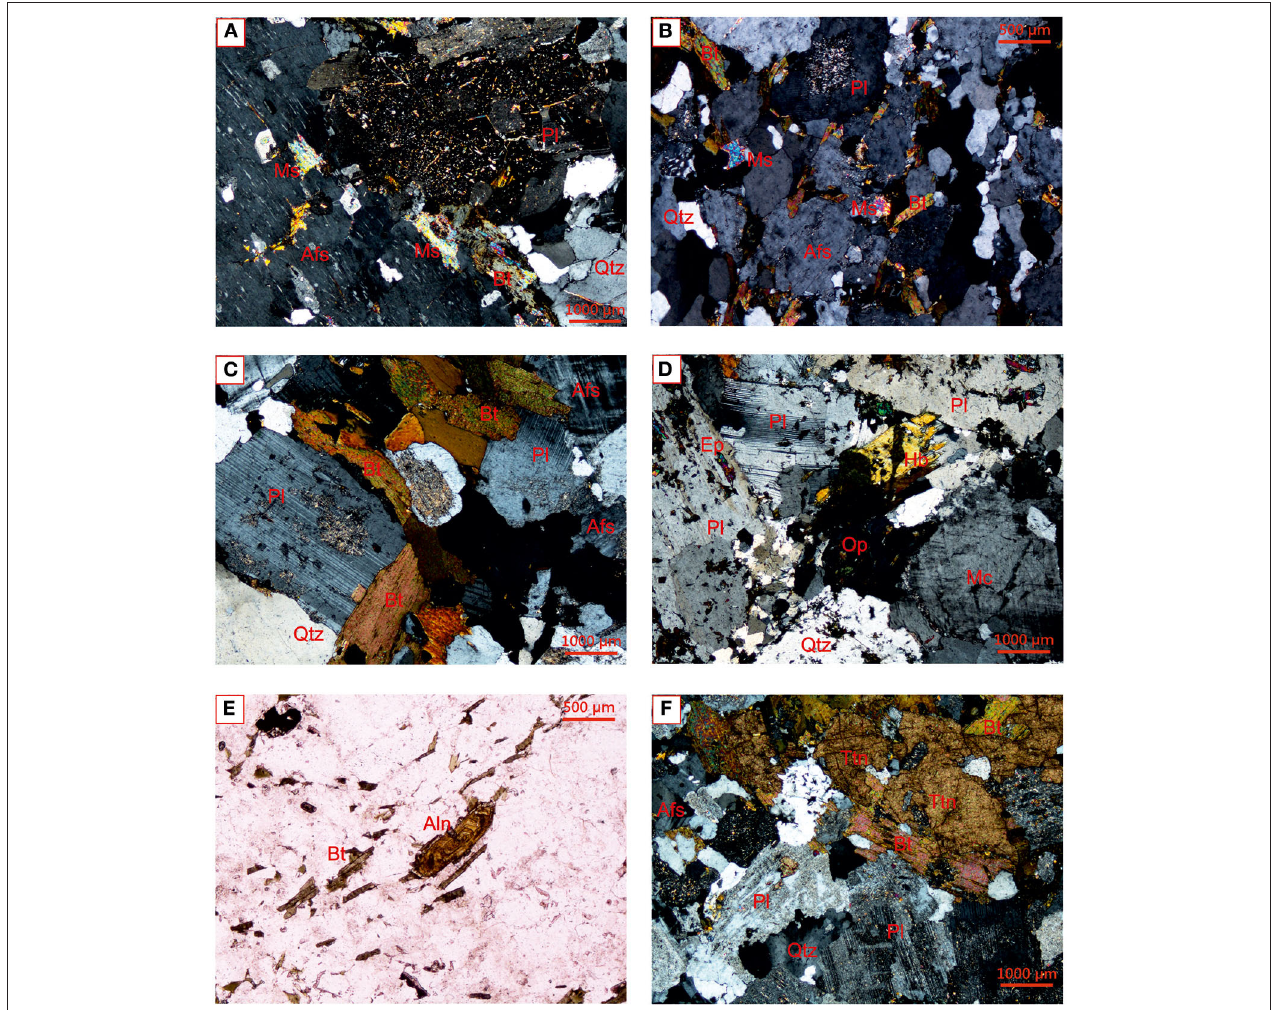
FIGURE 3 | Representative photomicrographs of Kanker granites (A) Biotite and two-mica granite with sericitized plagioclase, alkali feldspar with plagioclase and quartz inclusions, chloritized biotite, and muscovite. (B) Biotite and two-mica granite with plagioclase, alkali feldspar, quartz, biotite and muscovite. Quartz exhibits sub-grain formation. (C) Biotite granite with plagioclase, alkali feldspar, quartz and biotite. The alteration of plagioclase is limited to their cores and possess growth twins. (D) Hornblende biotite granite with hornblende, plagioclase, microcline, quartz and opaques. Plagioclase possesses deformational kinks. (E) An elongated zoned allanite grain observed in the biotite granite. (F) Biotite granite with large titanite grains associated with biotite, extensively sericitized plagioclase, alkali feldspar and recrystallized quartz. The mineral abbreviations in the figure are Ms, Muscovite; Afs, Alkali feldspar; Bt, Biotite; Pl, Plagioclase; Qtz, Quartz; Ep, Epidote; Op, Opaque; Mc, Microcline; Ttn, Titanite; Aln,